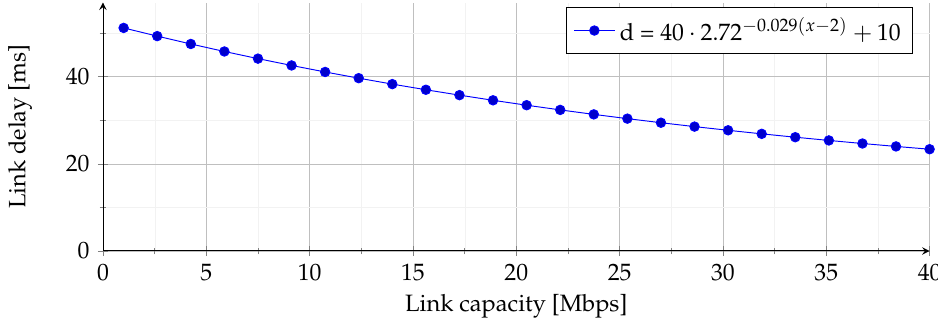
Figure 3. Propagation delay as a function of link capacity. The curve is fitted on two typical 5G values: d ( 50 ) = 20, d ( 200 ) = 100.